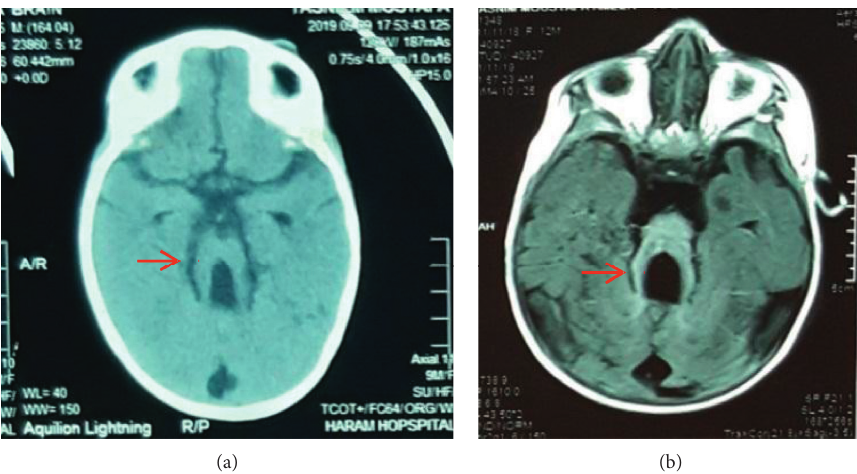
Figure 5: Axial brain imaging. Brain CTscan (a) and brain MRI (b) showing a molar tooth sign at the level of the midbrain (red arrows).